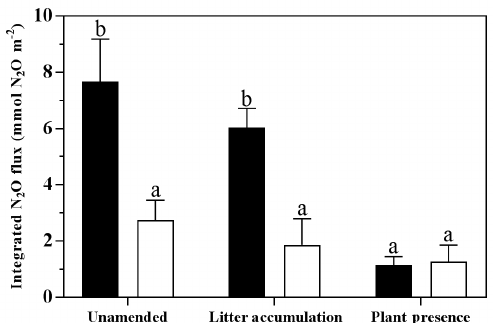
Figure 5. Integrated N 2 O fluxes over the 14-day period of ele- vated N 2 O emissions in the drying phase of the flooding–drying experiment (mean ± SE; n = 6). Black bars represent Model Soil 1 (macroaggregates 250–4000µm), whereas Model Soil 2 (microag- gregates < 250µm) is depicted as white bars. Significant differ- ences among the six treatments are denoted by different lower case letters at adj. P < 0 .